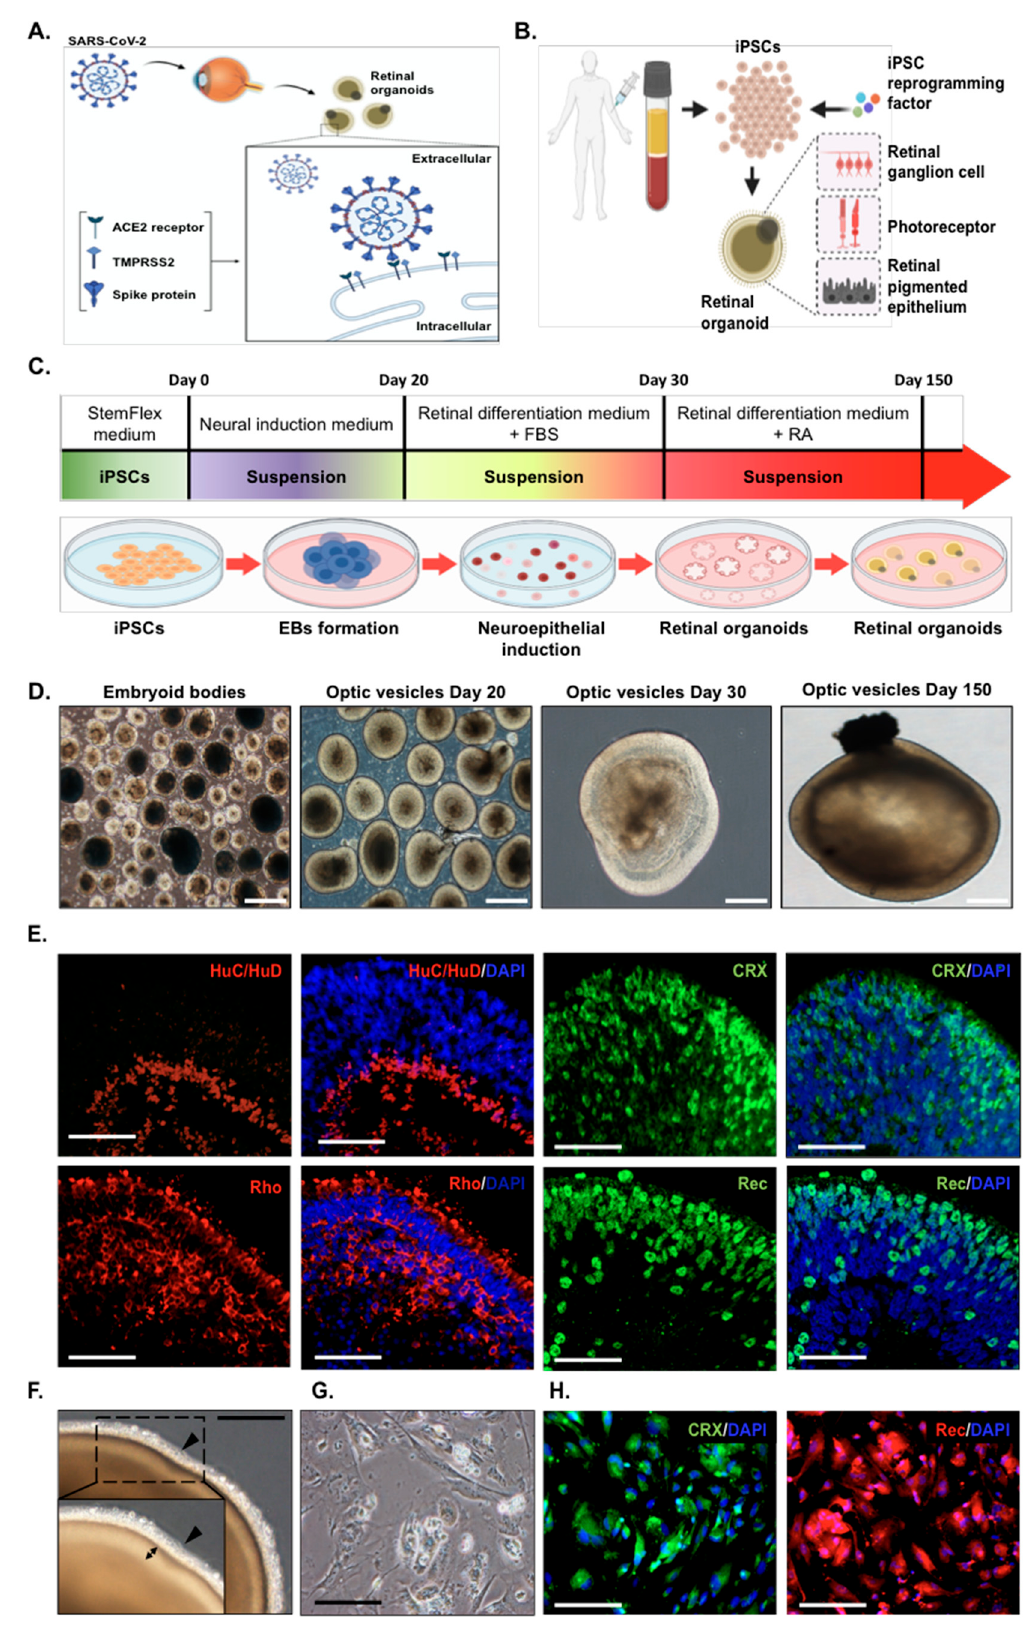
Figure 1. Establishment of human induced pluripotent stem cell (iPSC)-derived retinal organoids and monolayer cultures. ( A ) Schematic showing the examination of severe acute respiratory syndrome coronavirus 2 (SARS-CoV-2) infectivity in the human iPSC-derived retinal organoids. ( B ) Schematic illustrating the generation of human iPSC-derived retinal